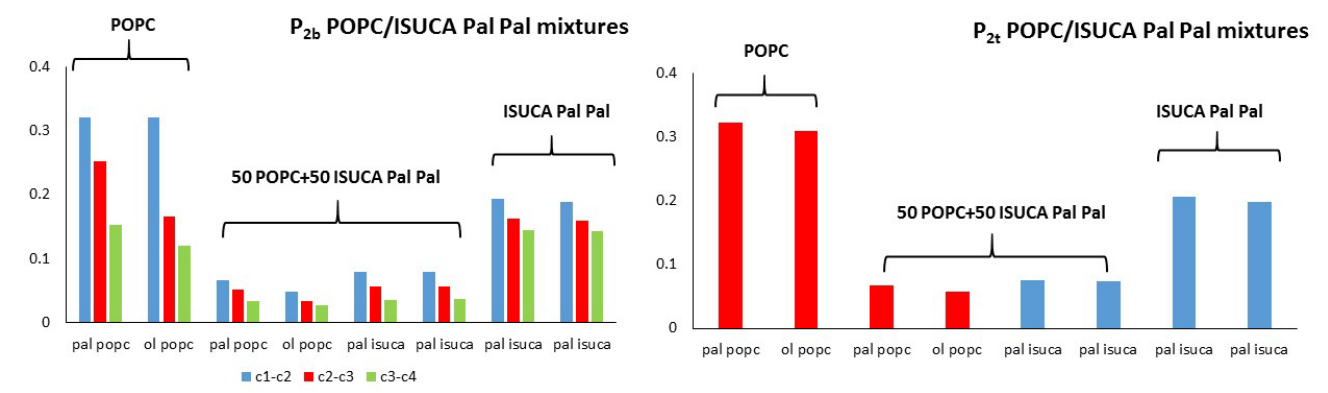
Figure 7. P 2t and P 2b for POPC/ISUCA-Pal Pal mixtures.